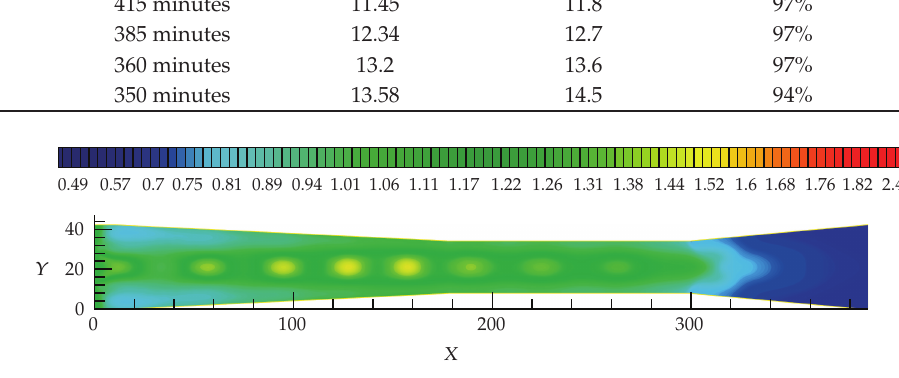
Figure 22: Density through the di ff user section at